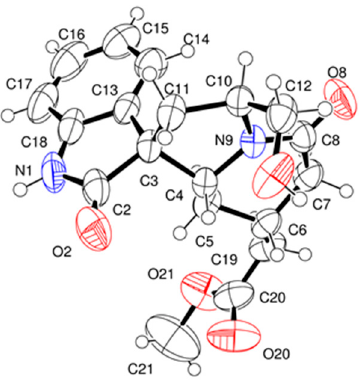
Figure 2. ORTEP plot of the X-ray structure of spiro[indolizidine-1,3 ′ -oxindole] 4 . Removal of the hydroxymethyl substituent, which plays a decisive role as an element